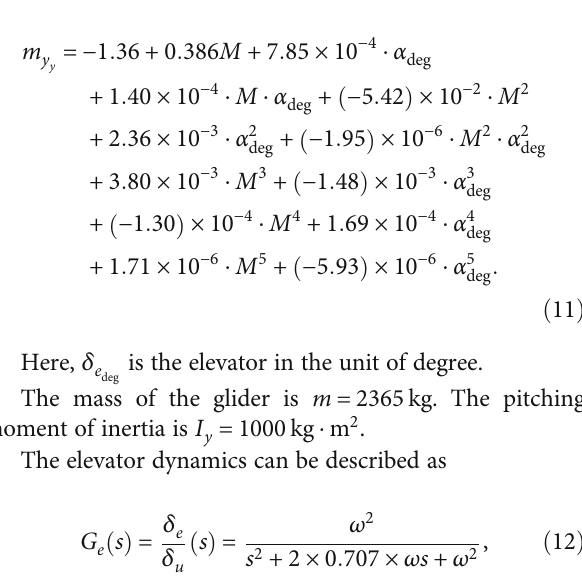
Figure 1: Drag coe ffi cient with respect to the Mach number and angle of